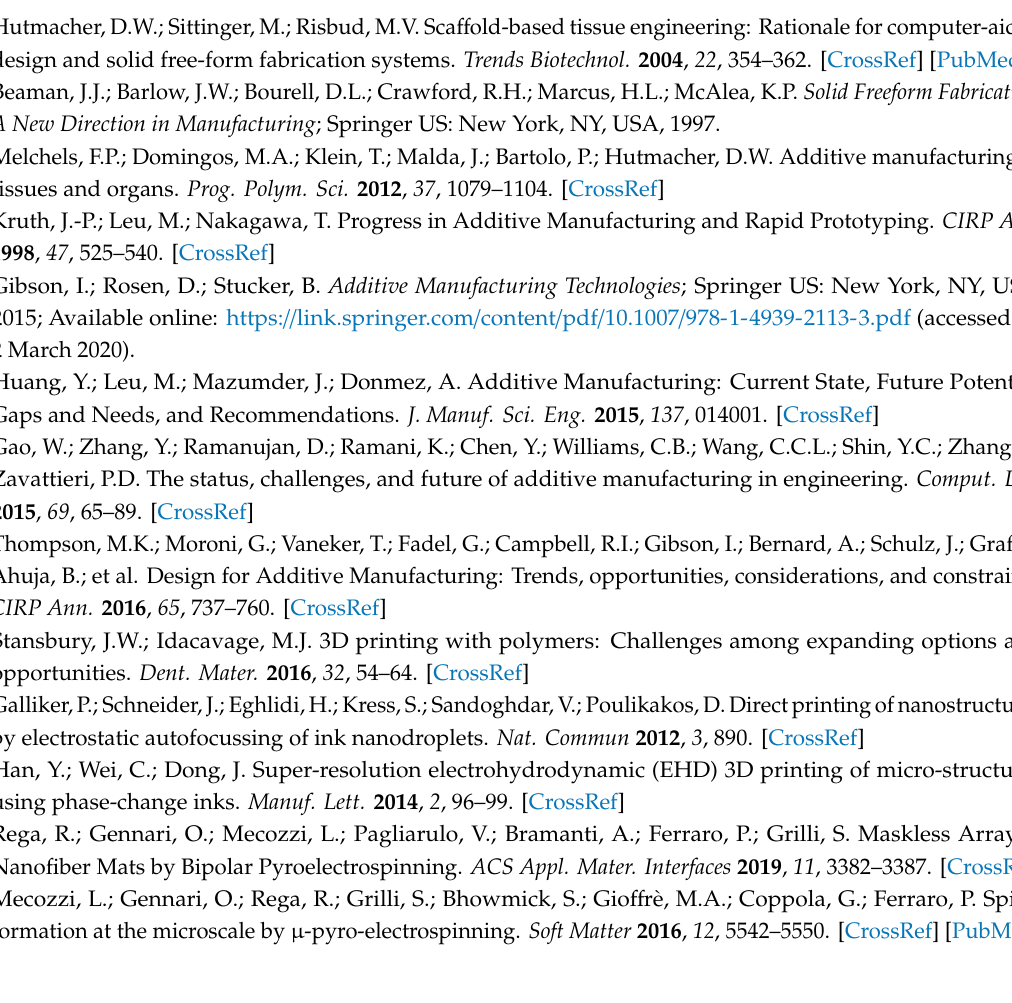
Table A2. Characteristics of the tensile samples after printing: Glass transition, Young’s modulus, ultimate tensile strength and tensile toughness.